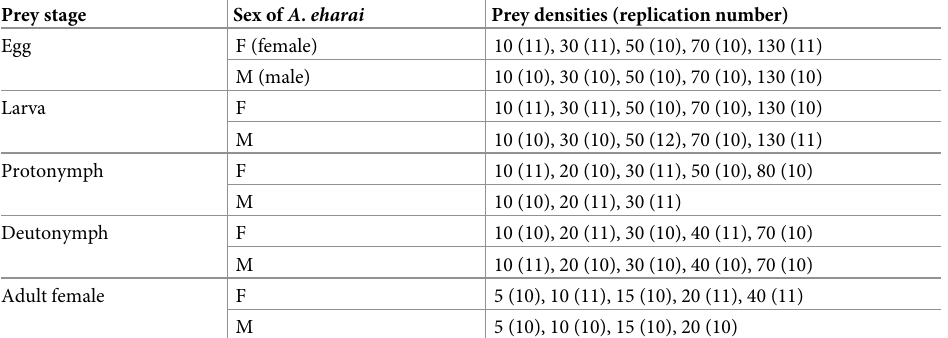
Table 1. Prey densities tested for the functional response test of Amblyseius eharai (both males and females) when fed various life stages of Tetranychus urticae as prey. Prey